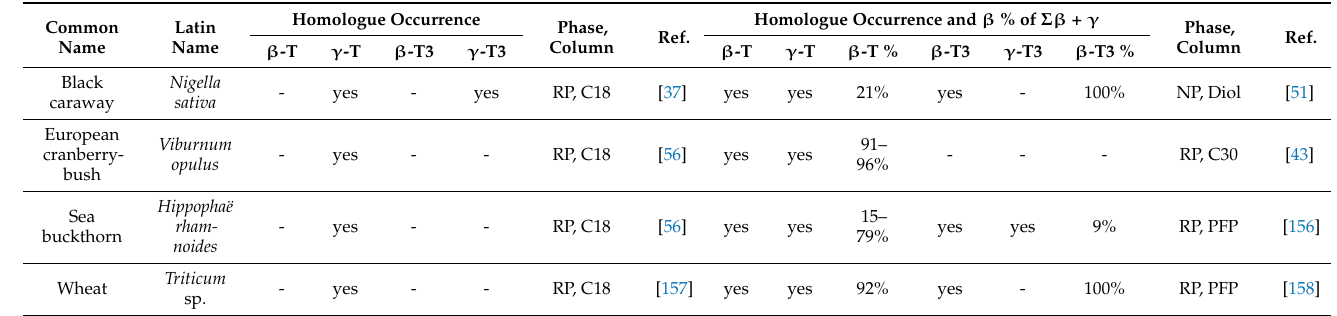
Table 1. Comparison of result interpretation of the tocopherol (T) and tocotrienol (T3) isomers ( β and γ ) determination in the same type of plant material by LC using different columns (C18, C30, PFP, and Diol) and elution order (NP and